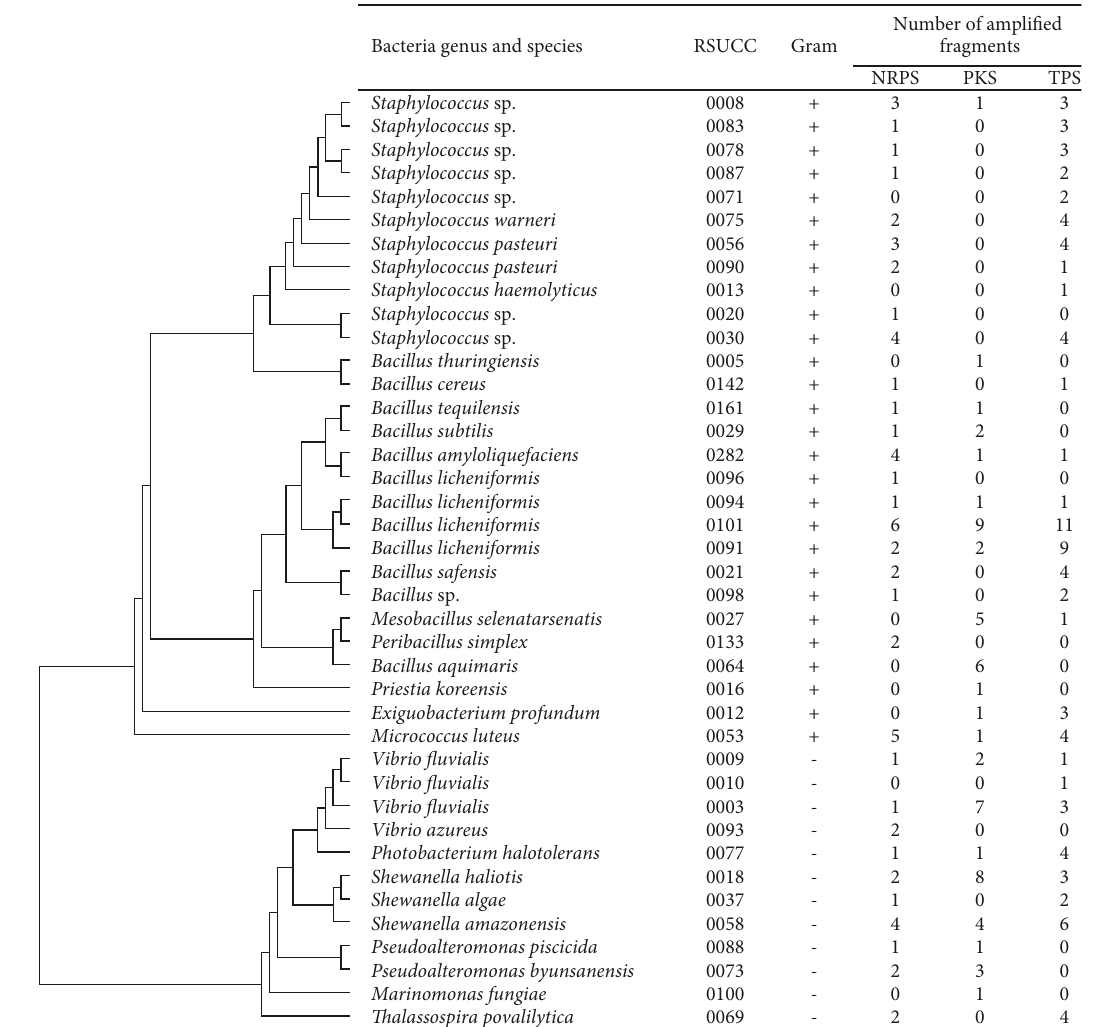
Table 2: Number of secondary metabolism gene fragments amplified from degenerate PCR of the 40 isolated bacterial strains overlaid with their